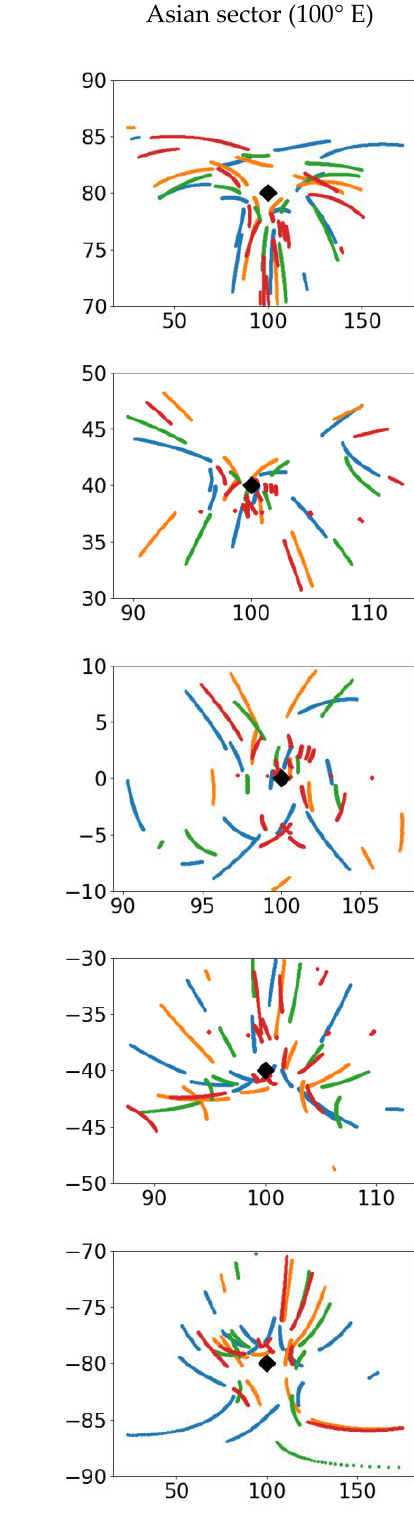
Figure 12. Ionospheric points within 12–13 UT 10 October 2020 at different latitudes in the American (mid column, − 100° E) and in the Asian (right column, 100° E) sectors. Dark blue points signify GPS, orange—GLONASS, green—Galileo, red—BeiDou. The black rhomb marks the station position. The station latitude is indicated on the left.